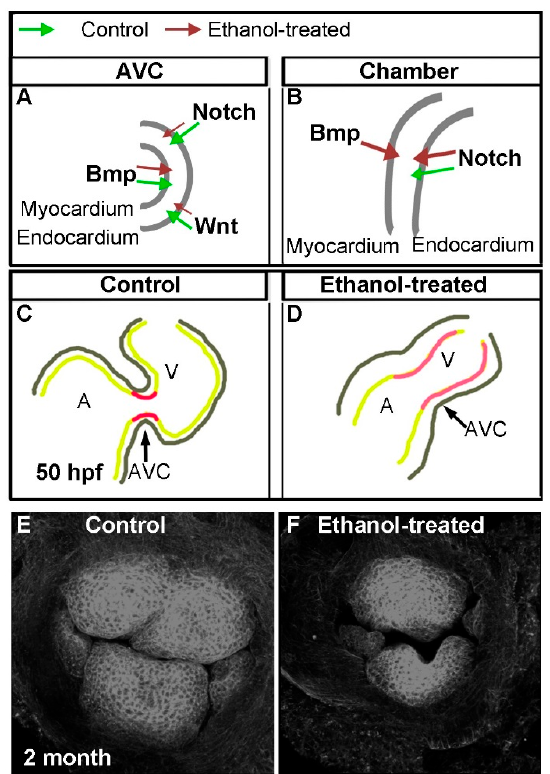
Figure 2. Zebrafish studies discovered altered valve regulatory pathways due to embryonic ethanol exposure leading to persistent atrioventricular valve defects. ( A ) Schematic representation of atrio-ventricular canal (AVC) showing myocardium and endocardium layers. Bmp, Notch and Wnt signaling play critical roles during AVC differentiation. Ethanol exposure reduced Notch and Wnt activity at the AVC (represented by small dark brown arrows ) during atrioventricular valve formation; ( B ) Schematic representation of the ventricle showing myocardium and endocardium layers. Ethanol exposure (3–24 hpf) increased Notch activity in the ventricle (represented by big dark brown arrows) during atrioventricular valve formation. Green arrow : normal condition; dark brown arrow : ethanol-exposed condition; ( C ) Schematic representation of atrium, ventricle and AVC ( black arrow ) of the control zebrafish heart at 50 hpf (during atrioventricular valve formation). Differentiated valve-forming cells ( red ) are localized at the AVC. Gray line represents myocardium layer; greenish-yellow line represents endocardial layer; ( D ) Schematic representation of the atrium, the ventricle and the AVC of the ethanol-treated (3–24 hpf) zebrafish heart at 50 hpf (during atrioventricular valve formation). Note that the shape of the heart is different from control. Differentiated valve-forming cells ( pinkish-red ), which do not exhibit all characteristics of normal valve cells are not restricted at the AVC. Those cells extend into the ventricle. The distance between myocardium and endocardium (the space containing cardiac jelly; black line ) is more in ethanol-treated embryos. Gray line represents myocardium layer; greenish-yellow line represents endocardial layer; and ( E , F ) Wheat germ agglutinin-stained atrioventricular valves of two-month-old zebrafish shows four well-organized valve cusps in control fish ( E ), and small, deformed valve cusps in fish treated with ethanol during embryonic development (3–24 hpf).